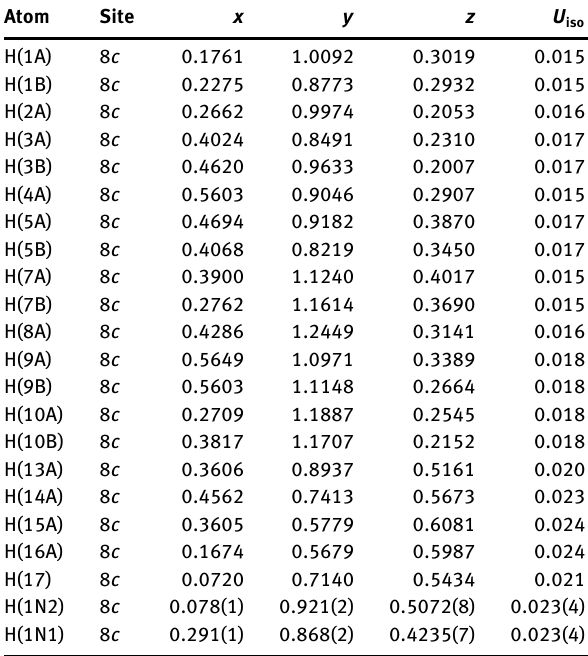
Table 2: Fractional atomic coordinates and isotropic or equivalent isotropic displacement parameters (Å 2